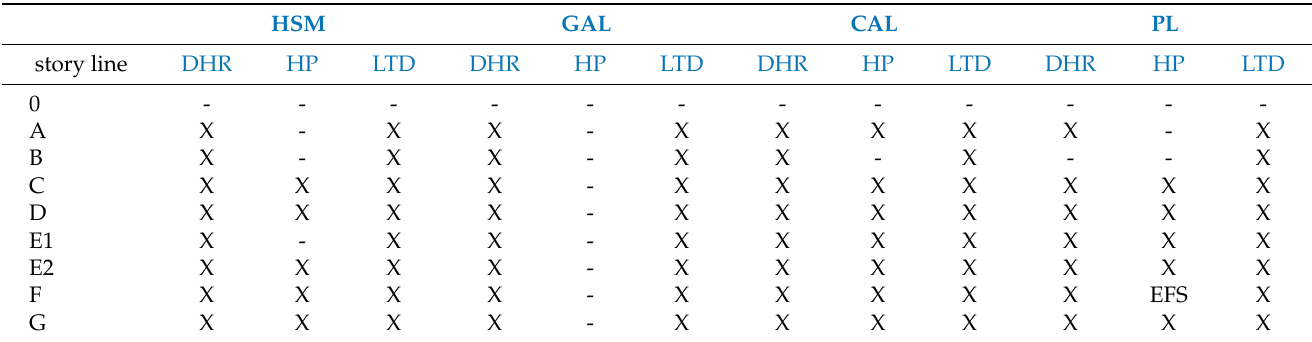
Table 4. Usage of heat recovery measures (X: used in both energy price scenarios, -: not used at all) for the HSM, GAL, CAL and